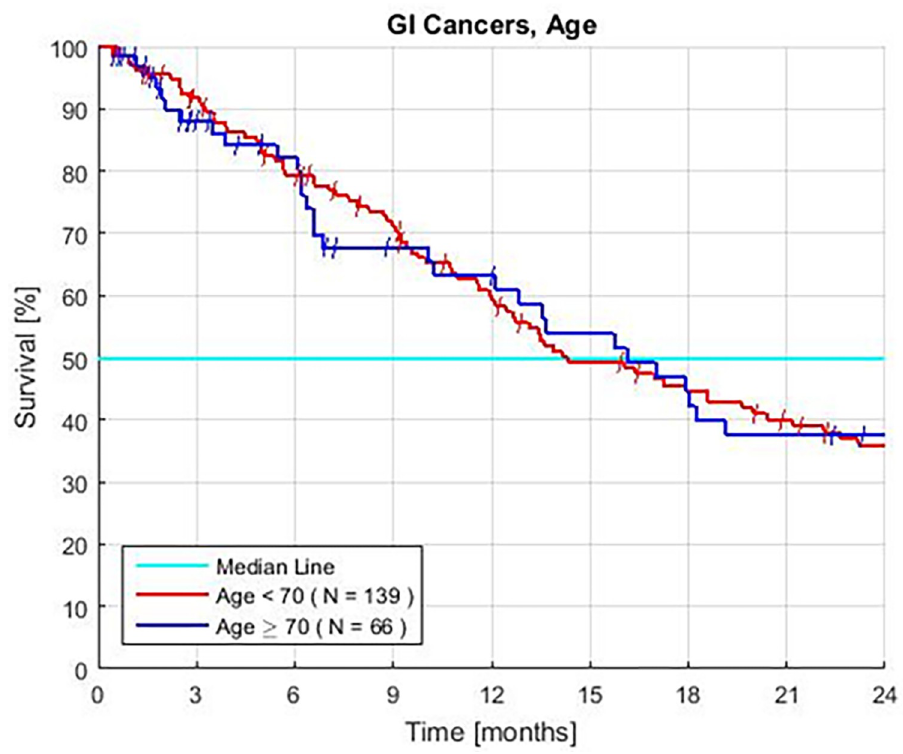
Fig 3. Kaplan Meier survival of advanced gastrointestinal cancer patients separated by age. Patients treated with GFLIO including resistant colon, pancreatic, and intrahepatic bile duct tumors, and no prior treatment (P = 0.77).